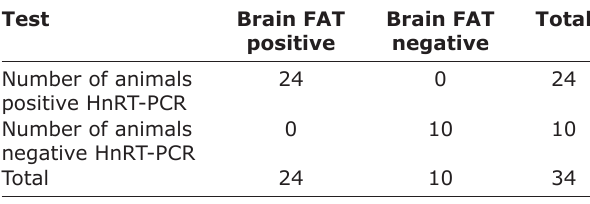
Table-2: Test results of FAT and HnRT-PCR. Test Brain FAT